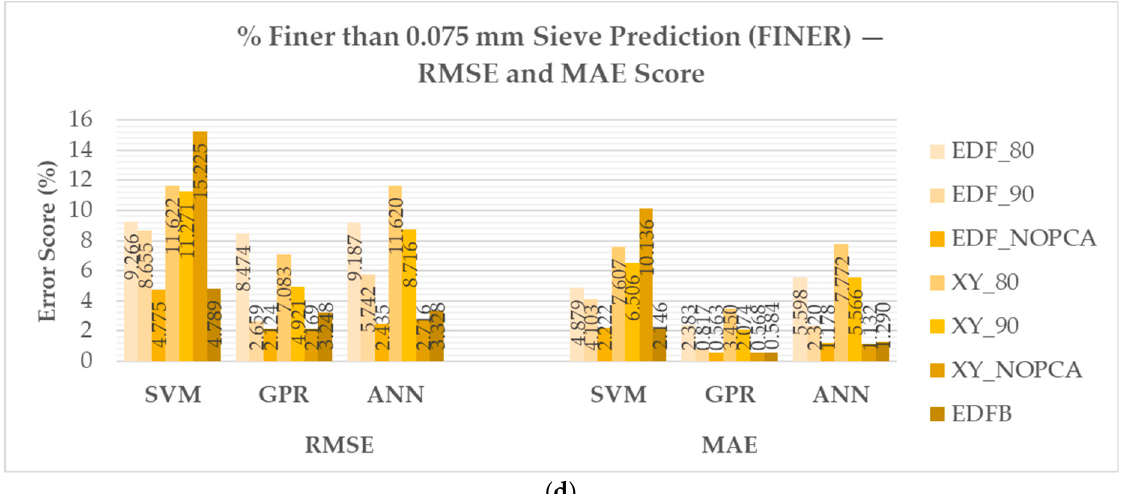
Figure 6. Regression EDF, XY, and EDFB machine learning model performance quantified by RMSE and MAE score for ( a ) GWL, ( b ) GWL, ( c ) SPTN, and ( d ) FINER model. The color legends indicate di ff erent form of Location Information modeling and the di ff erent status of PCA applied on the models.